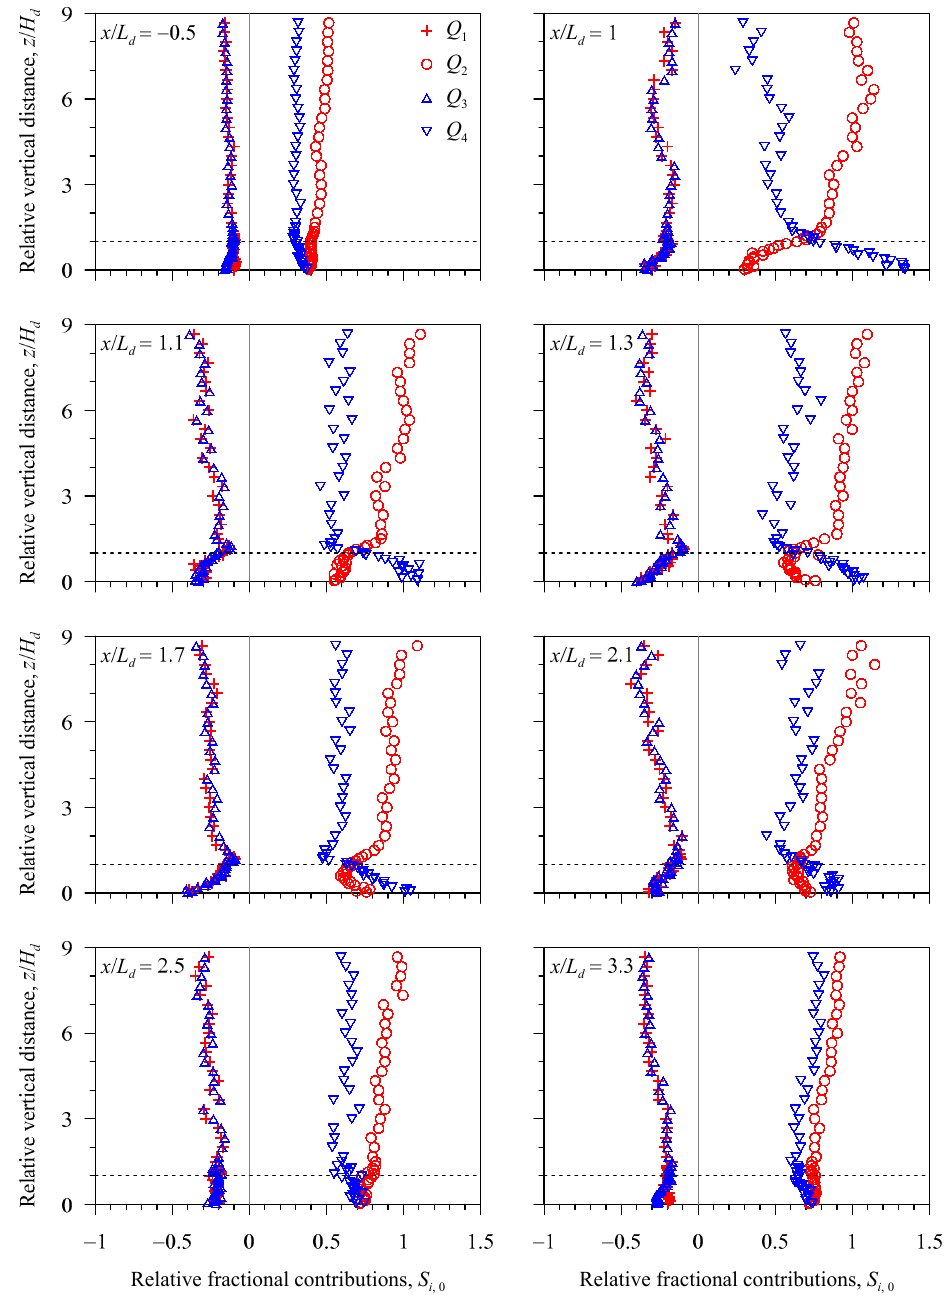
Figure 10. Vertical profiles of relative fractional contributions S i ,0 at various relative streamwise distances x / L d in Run 2.